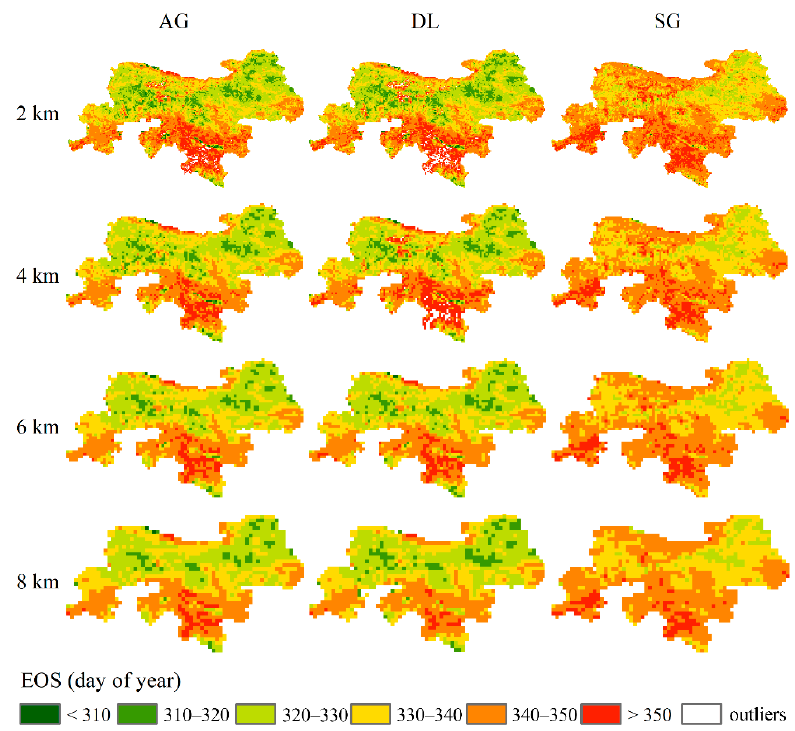
Figure A2. Up-scaled SOSs from 1000 m SOSs. (SG, Savitzky-Golay; AG, asymmetric Gaussian; DL, double logistic.)